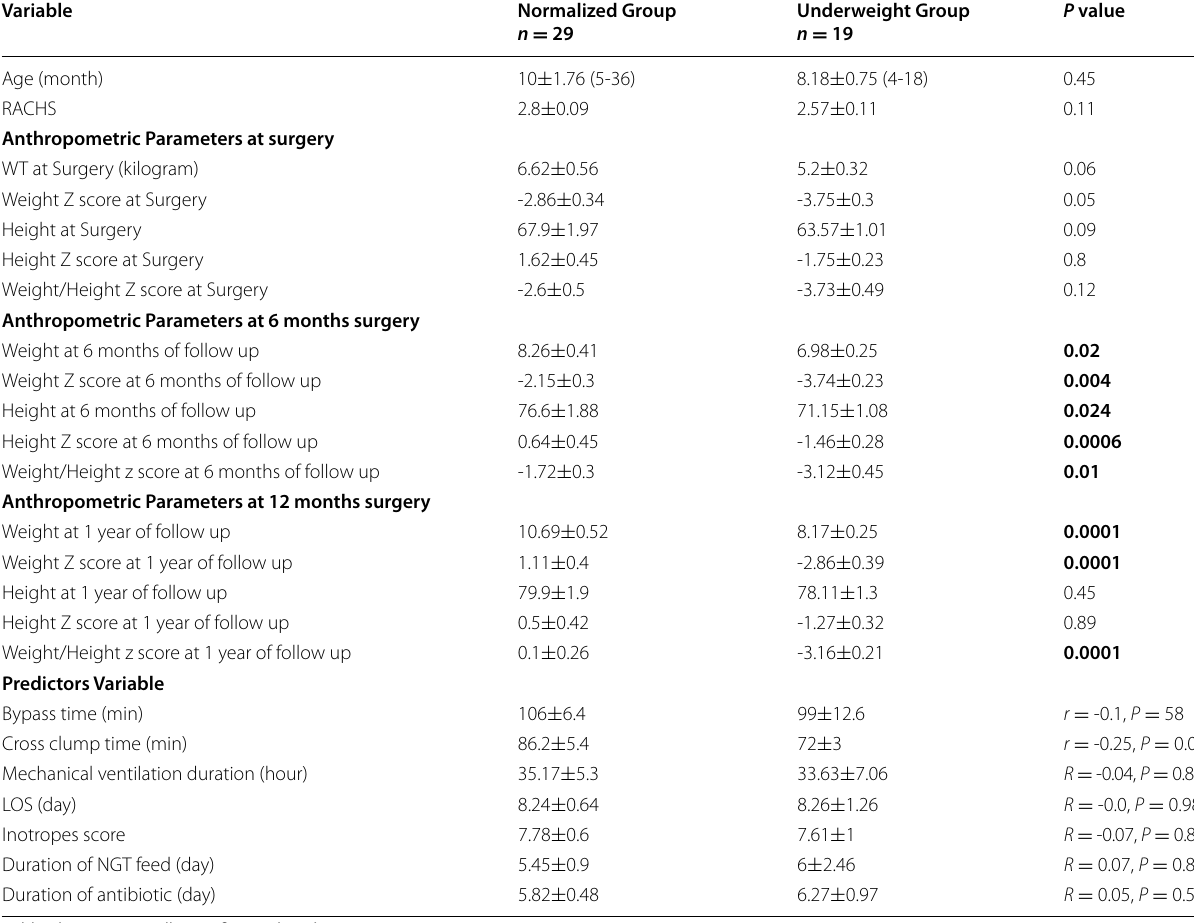
Bold indicate statistically significant p less than